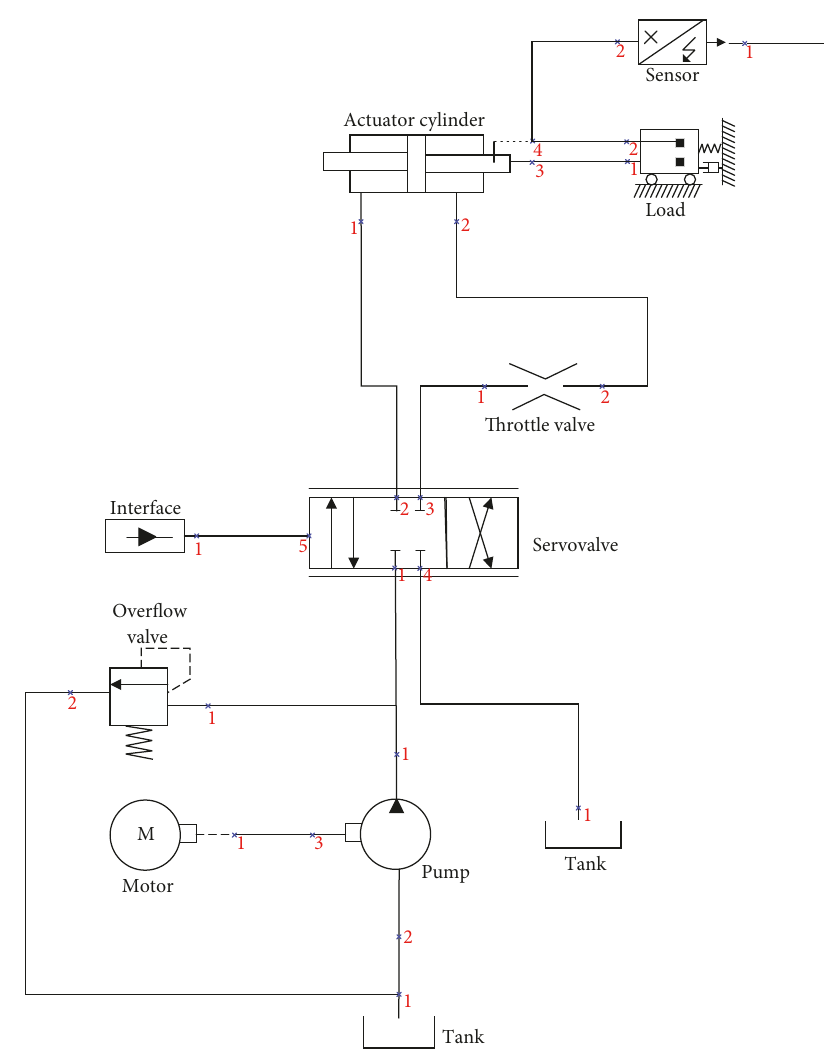
Figure 2: The failure injection model of mechanical hydraulic part using HyPneu.